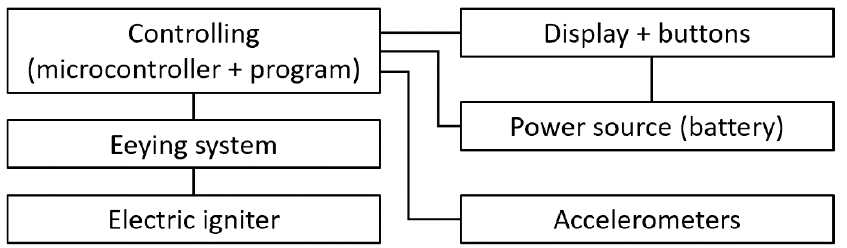
Figure 1. Block diagram of the time-type fuse.